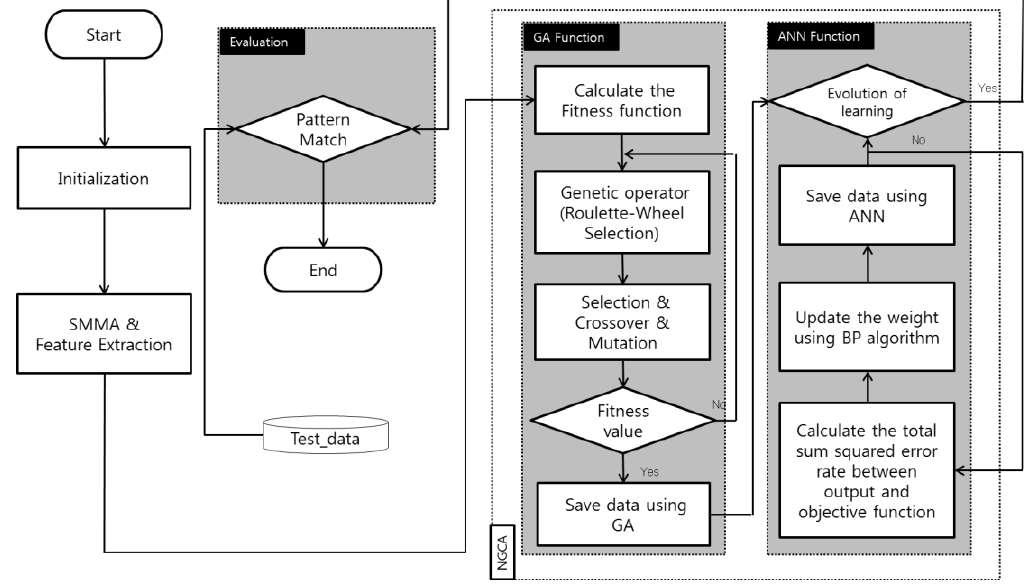
Figure 2. Flow of the pattern recognition algorithm used for